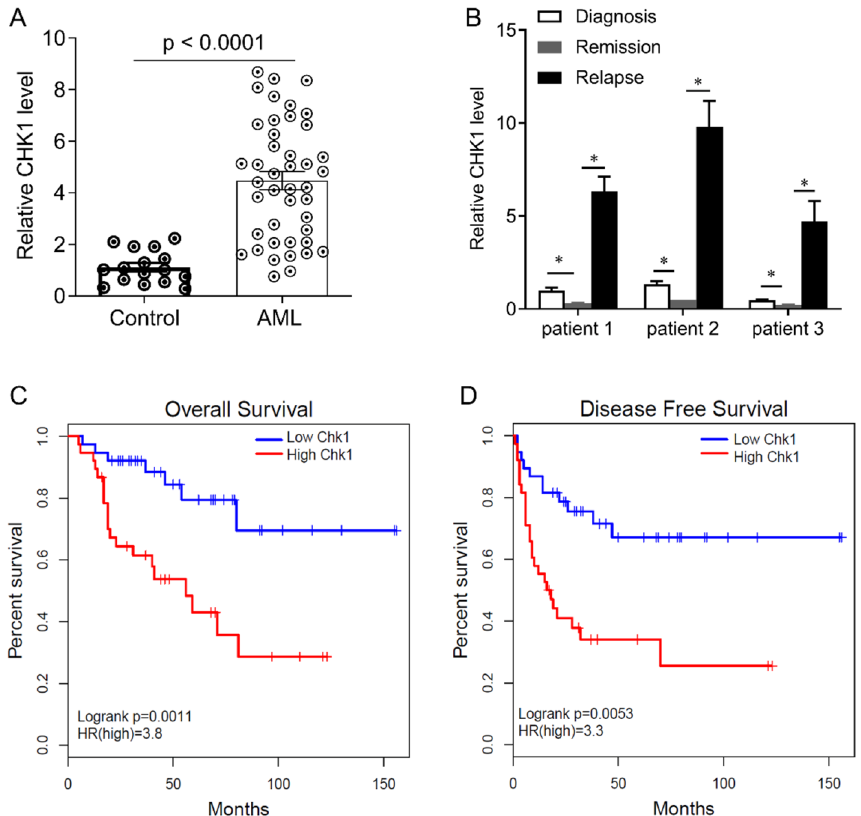
Figure 1. The relationship between the expression of CHK1 and the clinical outcome of AML patients. ( A ) The expression of CHK1 in AML and the control group. ( B ) CD34 + CD38 − cells were isolated from bone marrow samples of AML patients with three different disease stages (including new diagnosis, remission, and relapse), and CHK1 mRNA levels were examined. ( C ) Correlation between the expression of CHK1 and overall survival rate (P = 0.0011, Hazard rate (HR) = 3.8). ( D ) Correlation between CHK1 expression and disease-free survival rate ((P = 0.0053, Hazard rate (HR) = 3.3). The expression value is shown as mean ± SEM. *P <